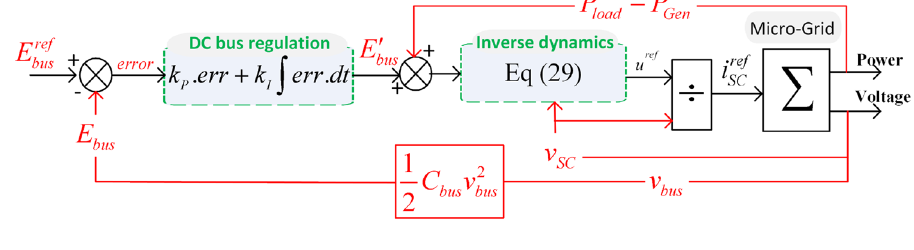
Fig. 8 The control scheme of supercapacitor